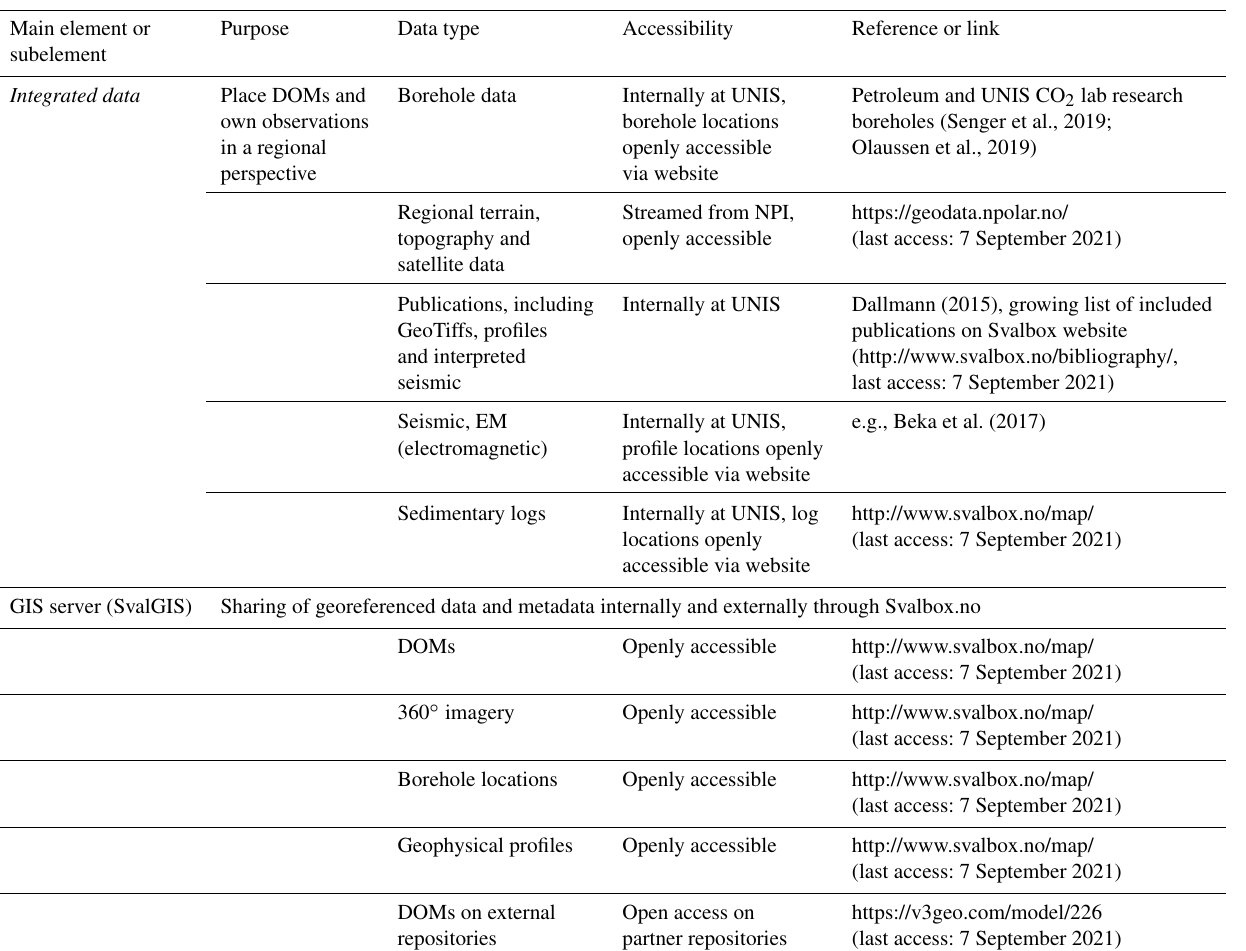
Figure 2. Overview of the Svalbox concept and its main elements. (a) Screenshot from the UNIS-internal part of Svalbox, illustrating the correlation of multi-scale sedimentological logs from the Festningen outcrop integrated within the Petrel platform. (b) Screenshot of the open-access part of Svalbox, with geological maps overlain with digital outcrop models, 360 ◦ imagery and geophysical data sets. Refer to Table 1 for details. Table 1.